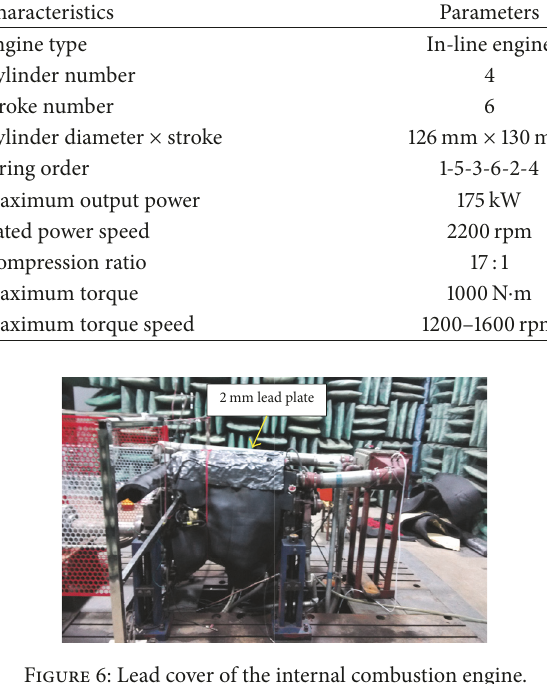
Figure 6: Lead cover of the internal combustion